Question: Describe this figure in one sentence.
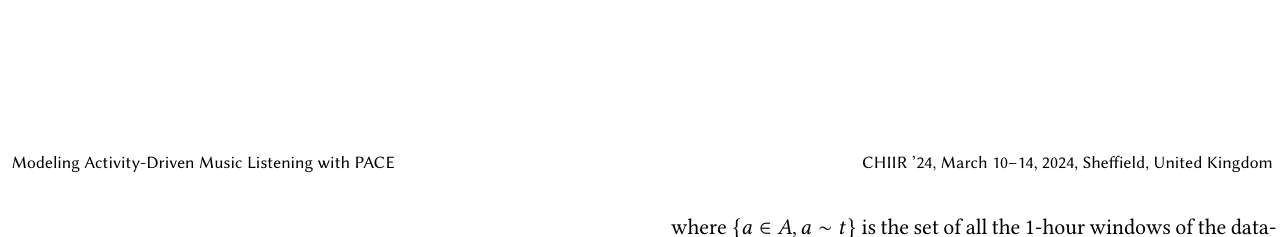
Answer: Aggregation process for a particular user: stream count over the whole dataset (top), weekly scale aggregation (middle), after convolution and normalization (bottom).